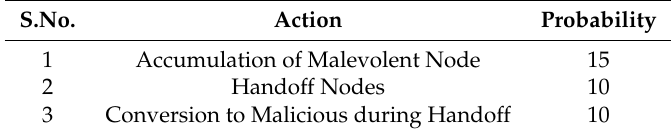
Table 3. Dissimilar probabilities for the performance scrutiny of the given